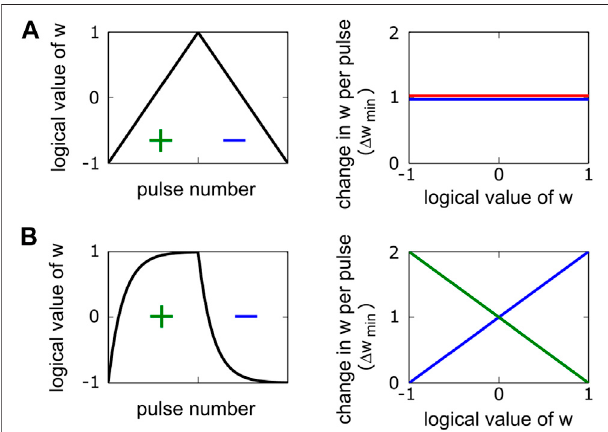
FIGURE 1 | Pulse responses and weight modulation characteristics are illustrated for two different devices. (A) Symmetric and linear device: Weight increments(red)anddecrements(blue)areequalinsizeanddonotdependon the weight. (B) Exponentially saturating device: Weight increments and decrements both have linear dependencies on the weight. However, there existsasingleweightvalueatwhichthestrengthsoftheweightincrementand decrementare equal. This point is called the symmetry point, and itisat w (cid:1) 0 for the illustrated